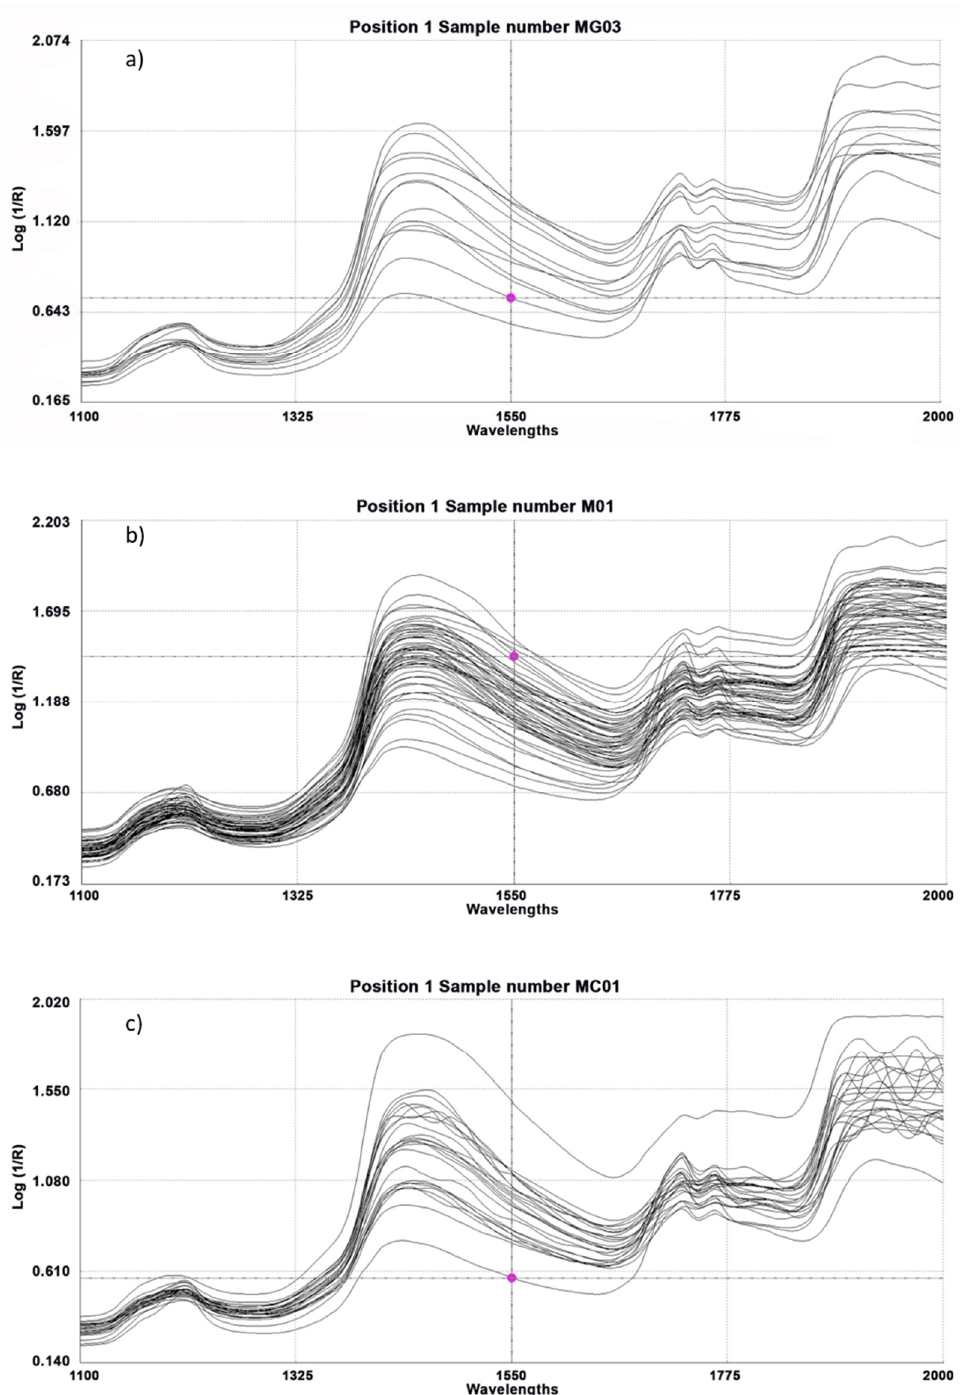
Figure 1. Near Infrared Spectroscopy ( NIR) spectra obtained from a remote reflectance fiber-optic probe applied directly to samples of ham. ( a ) 100% Iberian animals fed in “montanera2 (IM), ( b ) Iberian animals fed in “montanera” (CM) and ( c ) fodder-fed Iberian animals (CC).